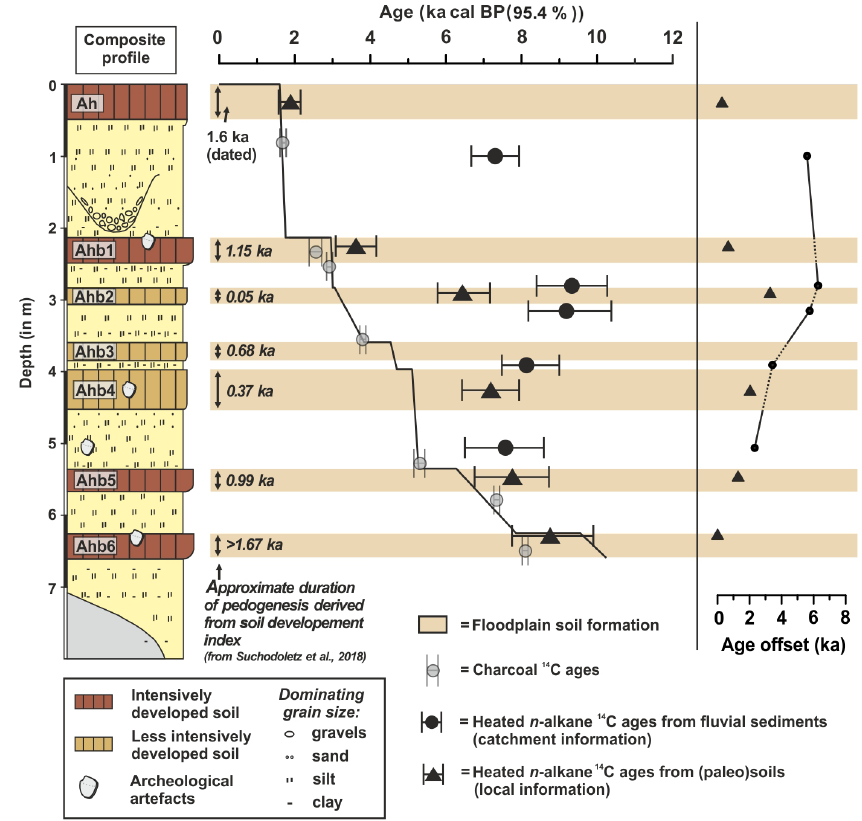
Figure 6. Chronostratigraphy of the investigated FSPS with n -alkane 14 C ages after heating with 120 ◦ C for 8h from (paleo)soils and fluvial sediment layers. 14 C ages are given as calibrated age ranges in kacalBP (95.4%) with the calibrated median age. Please note the shorter timescale ( x axis) compared with Fig.